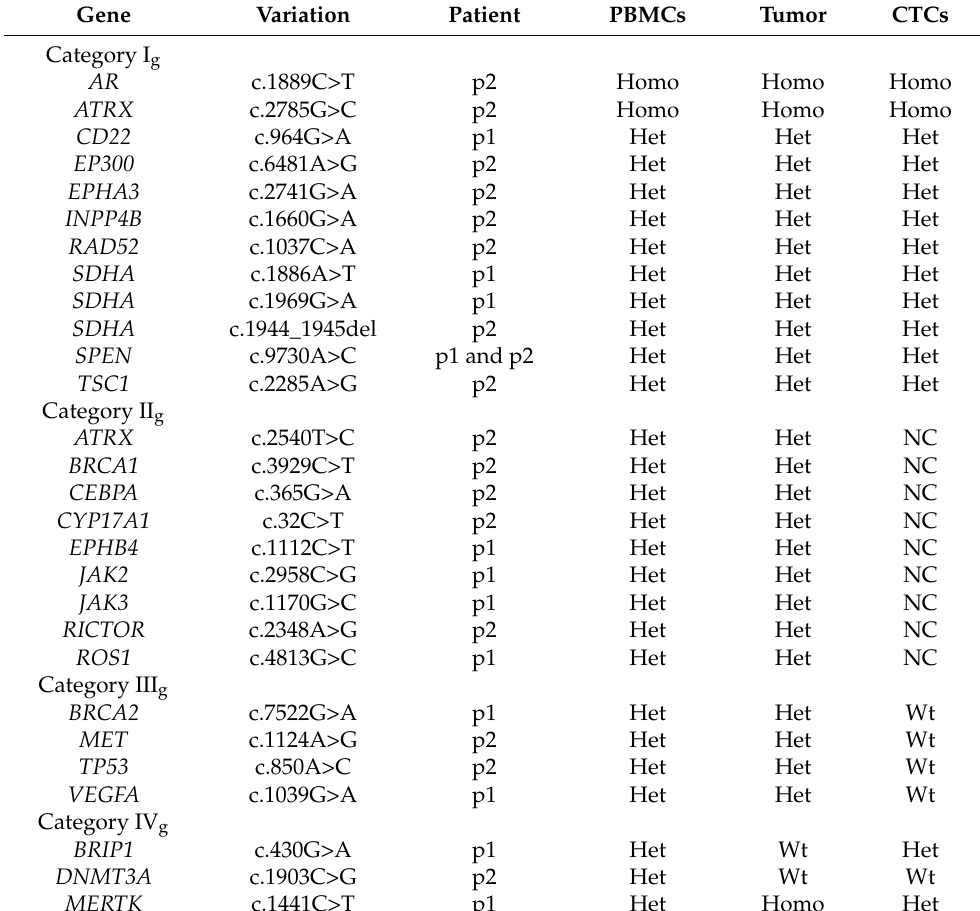
Table 1. Germline variations detected in peripheral blood mononuclear cells (PBMCs) of the two patients with epithelial ovarian cancer